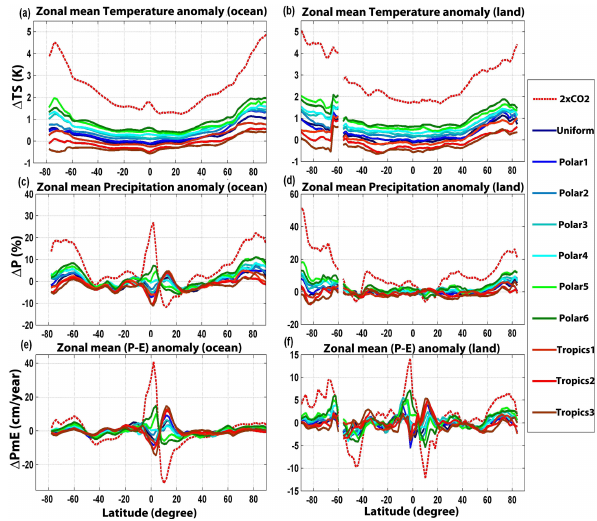
Figure 6. Changes in zonal mean surface temperature ( 1 TS), pre- cipitation ( 1 P) and precipitation minus evaporation ( 1 PmE) over ocean (left panels) and land (right panels). (a) and (b) : Zonal mean 1 TS increases monotonically with increase in the magnitude of maximum concentration of aerosols over poles and decreases with increase in the magnitude of tropical maximum. (c) and (d) : polar maximum causes enhanced precipitation. (e) and (f) : polar max- imum causes enhanced precipitation minus evaporation. Results shown are averages of the last 30 years of 60-year simulations.